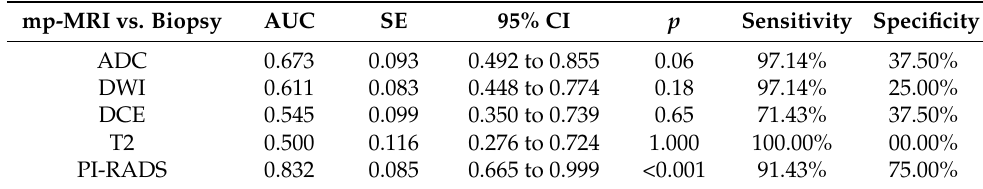
Table 2. Receiver operating characteristic (ROC) curve results for the level of agreement between mp-MRI and biopsy in active surveillance of prostate